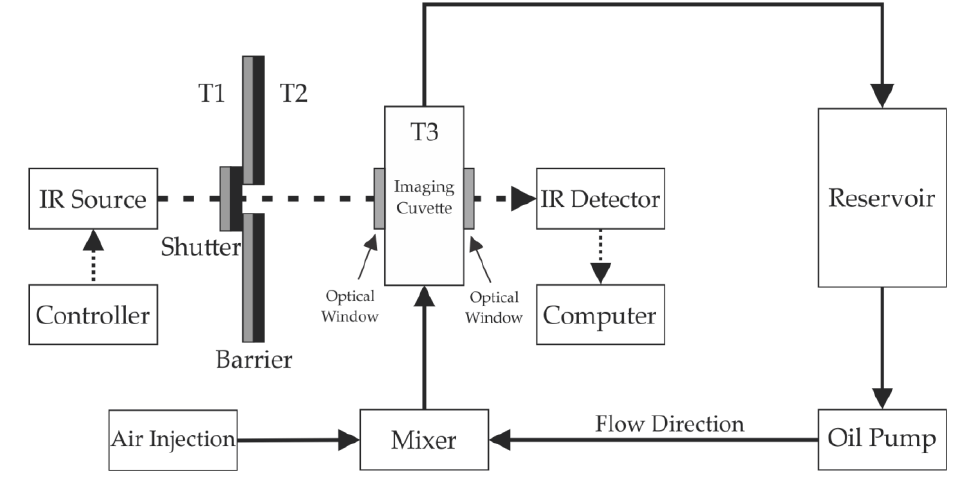
Figure 1. Experimental setup with IR detection and crude oil-air flow.